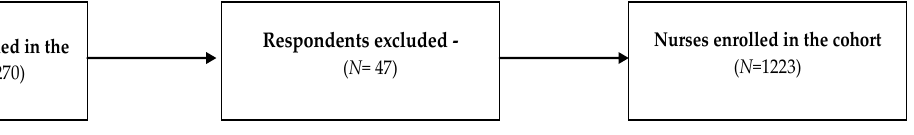
Figure 1. Flowchart of the recruitment process.